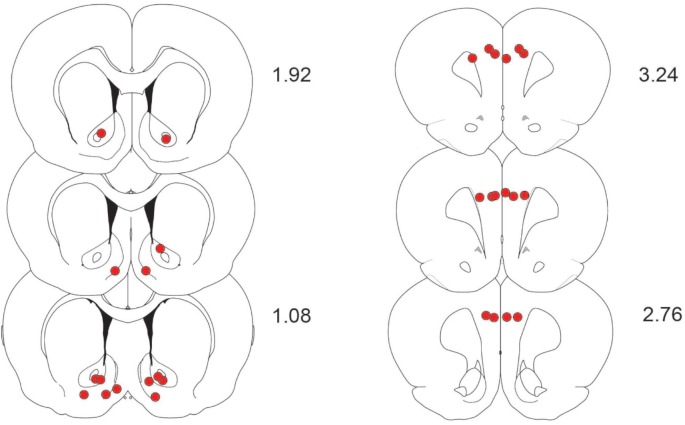
Cannulae placements for Experiment 3A hM4Di expressing rats.Individual placements in nucleus accumbens (NAc) and medial prefrontal cortex (mPFC).